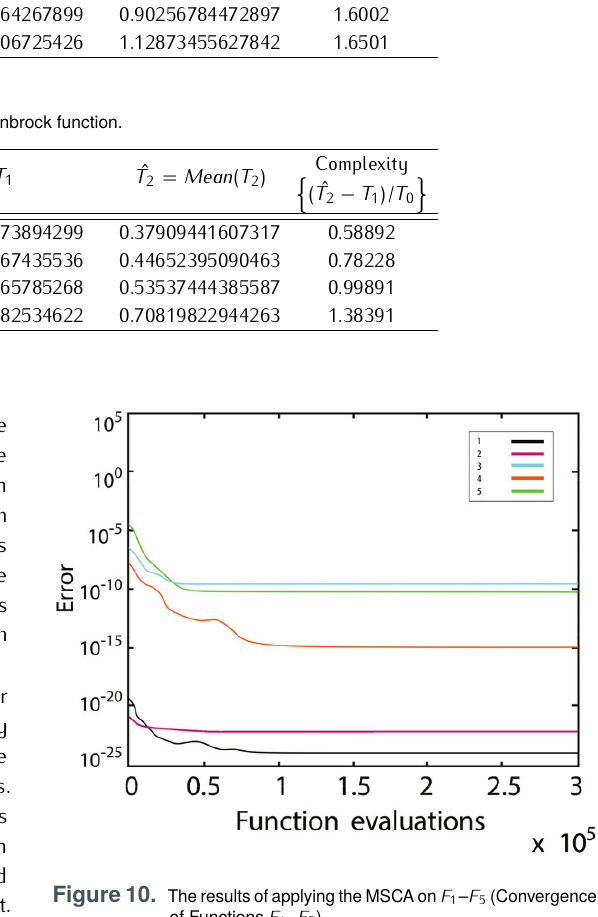
interruptions. For instance, when some weak members